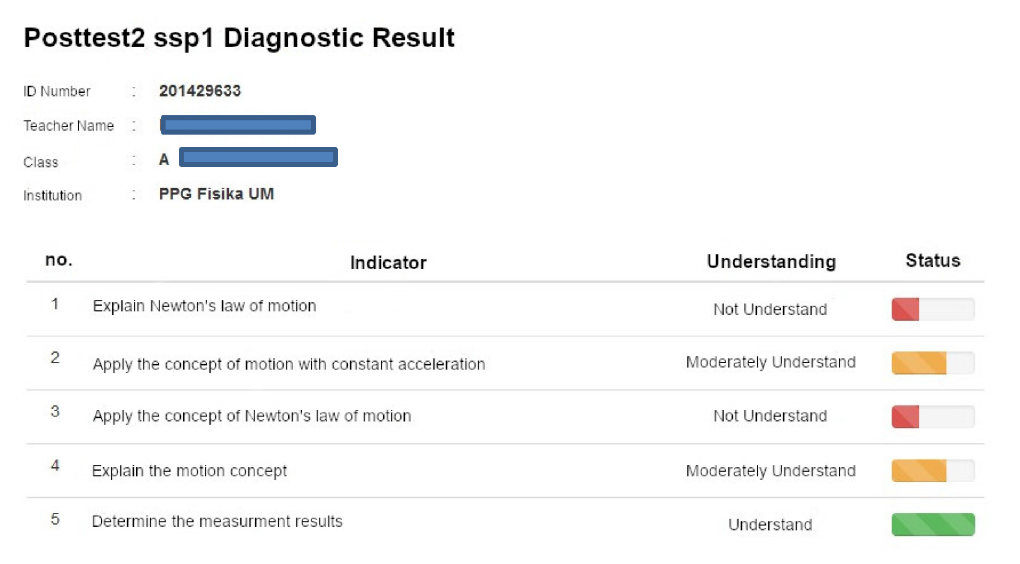
Figure 4. Example of Individual Student